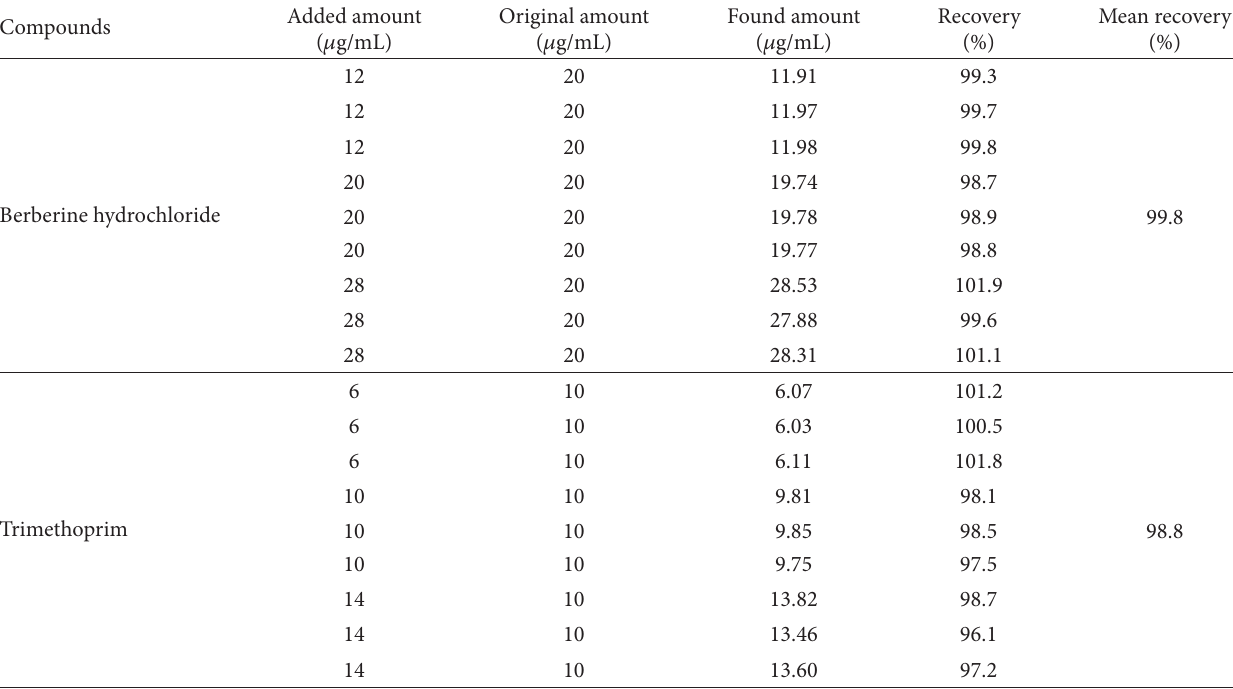
T 2: Recovery data of berberine hydrochloride and trimethoprim from